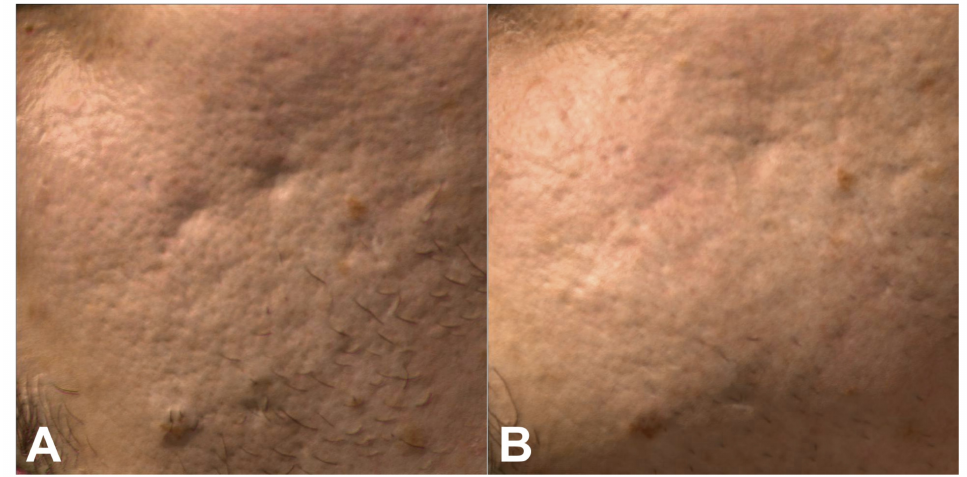
Figure 3. Patient 14 before ( A ) and 3 months after ( B ) treatments at multispectral analysis. The most common immediate post-treatment side effects were erythema, edema, and exfoliation that resolved within 10 days. No prolonged erythema and no pigmentation alterations were reported at 12 weeks after treatment. No severe adverse events were observed. Post-inflammatory hyperpigmentation was not observed in our study. Patients’ characteristics are reported in Table